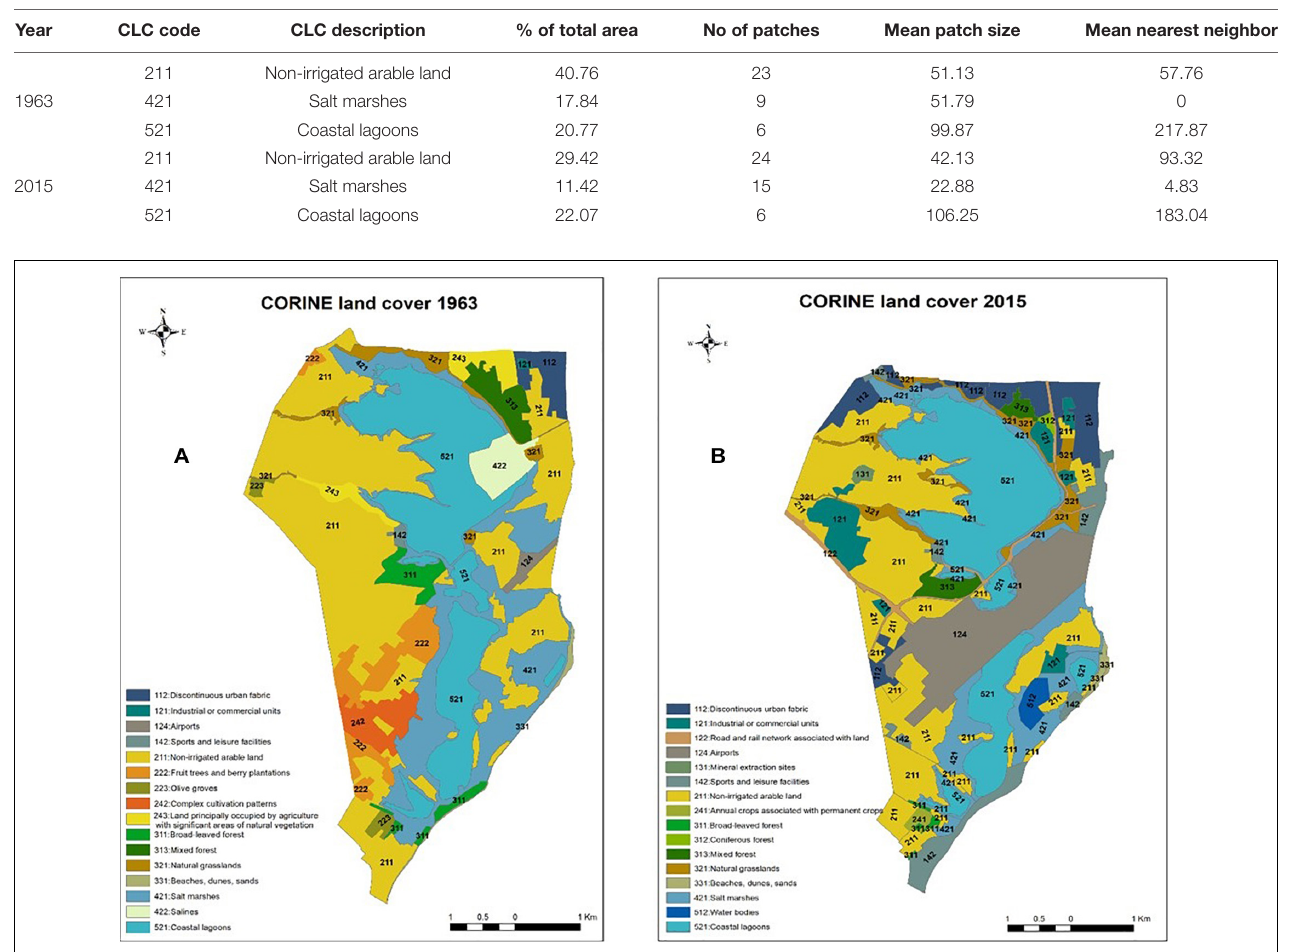
TABLE 4 | Landscape metrics of the Dominant land cover types.